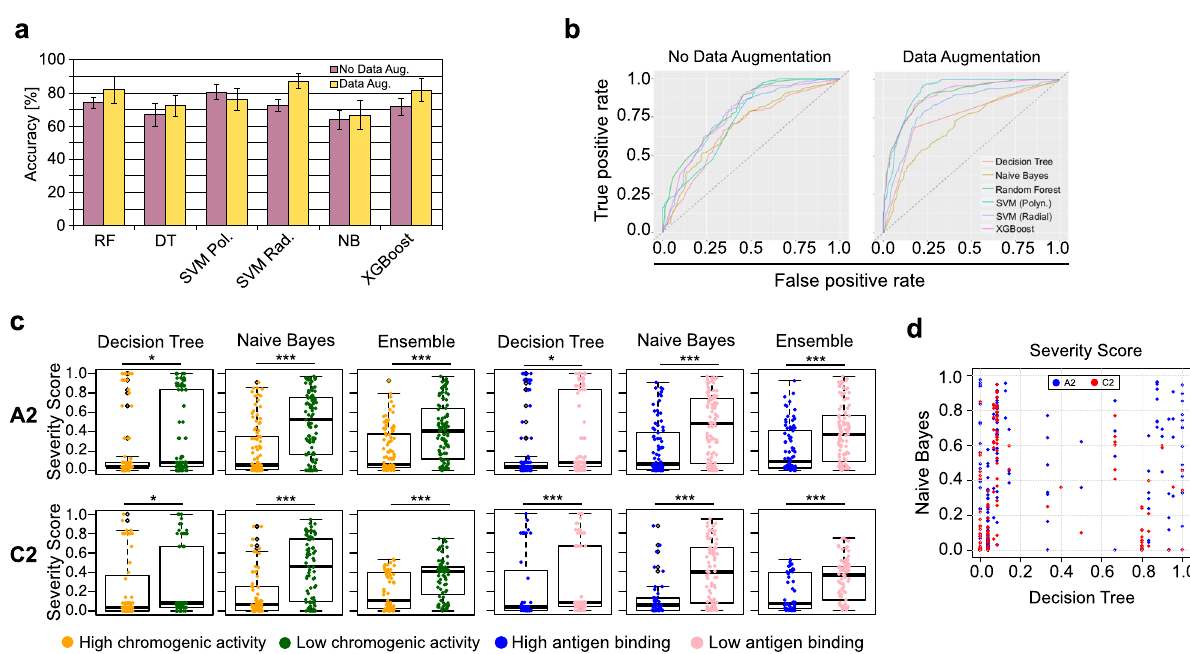
Fig. 2 Machine-learning classi fi er properties. a Comparison of the accuracy of the different classi fi ers. These are the averages of 10-fold cross-validation for each classi fi er. The bars depict mean values and error bars, the standard deviation. b The AUC (Area Under the Receiver Operating Characteristic curve depicts the relation between the true positive and the false-positive rates. Points close to (0,1) indicate a better classi fi cation. The diagonal line represents a random classi fi er for a class-balanced dataset, i.e., any result below this line is worse than assigning labels randomly. c Distribution of the Severity Scores of two classi fi ers and an ensemble, and their relation to the in vitro chromogenic activity and the expression/secretion ability of the in vitro FVIII mutant constructs. In total, 344 alanine mutants were used (205 for A2 and 139 for C2). The boxplots depict the median (centerline), the fi rst and third quartiles (lower- and upper-bounds), and 1.5 times the inter-quartile range (lower- and upper whiskers). Each dot in the plot is an amino acid mutation (i.e., an in vitro alanine mutant construct). d The Severity Score prediction of two classi fi ers for the chromogenic activity of FVIII mutants. The lack of correlation indicates that the classi fi ers are assigning different probabilities for the same instance — namely, having a different perspective about the real classi fi cation of mutants; this observation led us to combine their prediction values to come closer to the real activity of FVIII mutants. In all cases, we used the unpaired, two-sided Wilcoxon test (*** indicate p values < 0.001; ** p value < 0.01; * p value < 0.05). SVM support vector machine, DT decision tree, NB naïve